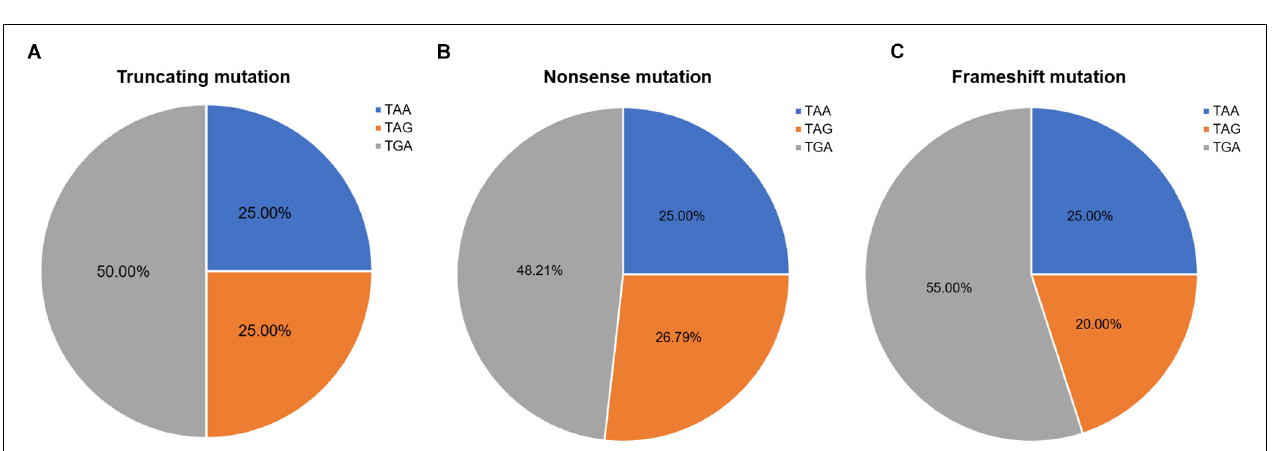
FIGURE 6 | Ratios of premature termination codons. The constituent ratios of premature termination codons in (A) truncating, (B) nonsense, and (C) frameshift mutations.